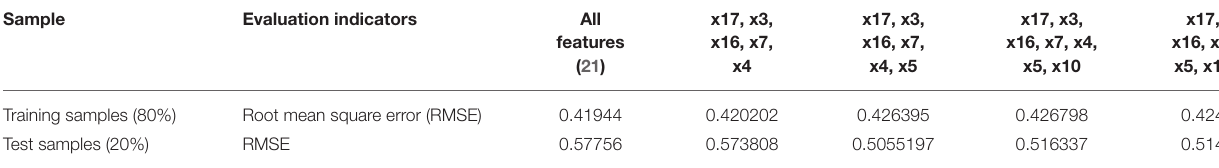
TABLE 4 | XG-boost’s five-fold crossover experiment results.